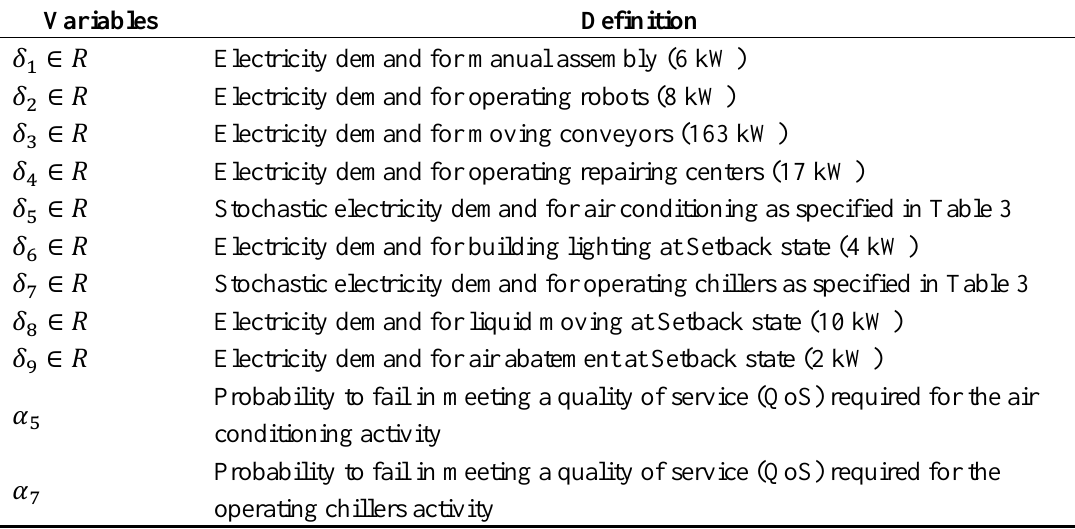
Table 5. Definition of parameters in the